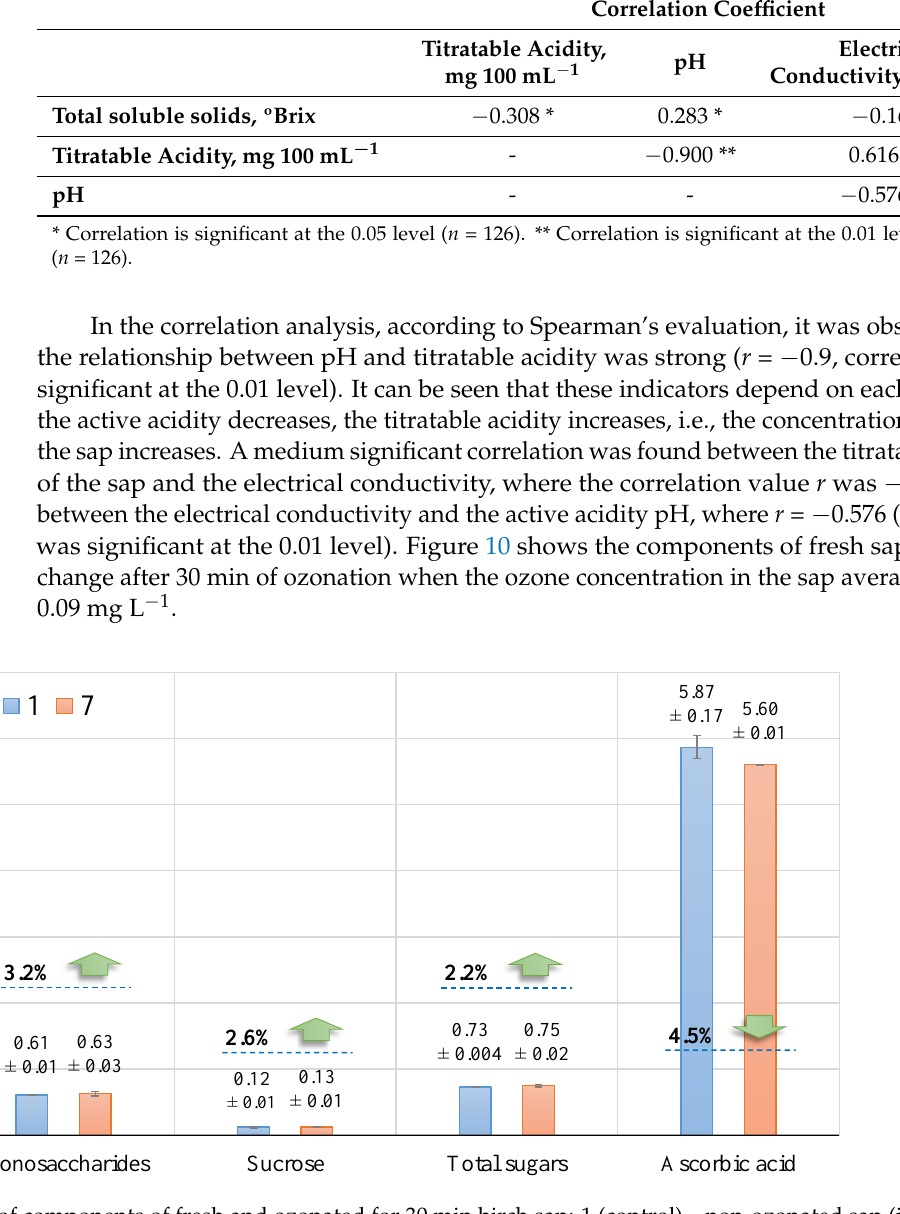
Figure 10. Comparison of components of fresh and ozonated for 30 min birch sap: 1 (control)—non-ozonated sap (initial); 7—sap ozonated for 30 min. Data are presented as means ± standard deviations ( p < 0.05, n = 6).